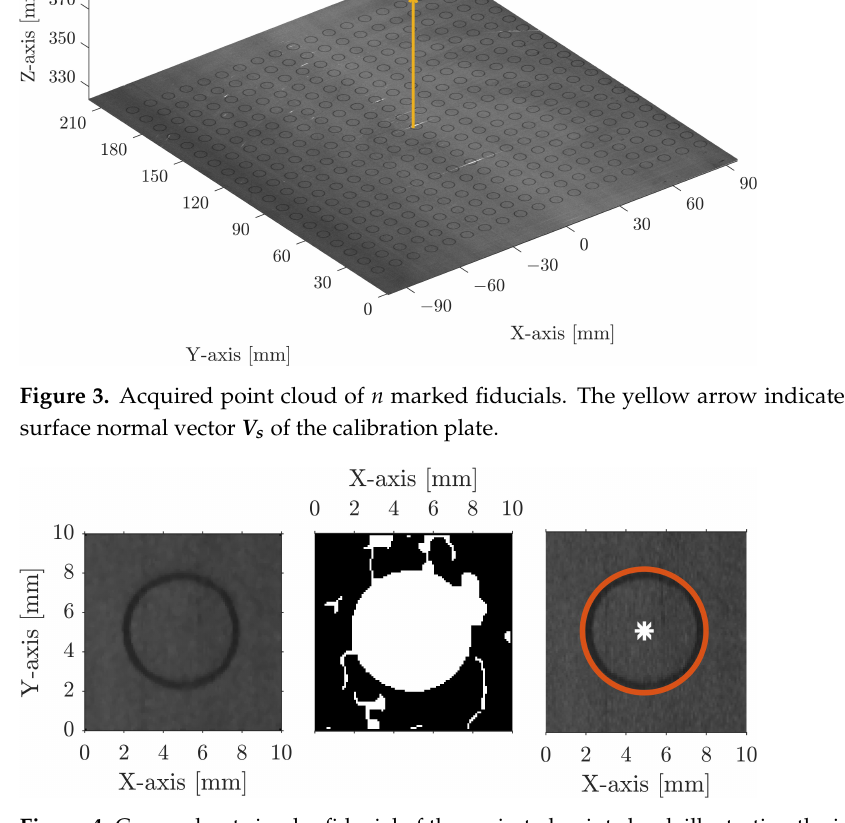
Figure 4. Cropped out circular fiducial of the projected point cloud, illustrating the image processing steps to locate the fiducials. A median filter is applied to the image ( left ), Canny edge detection and morphology ( centre ), and identification of circular patterns using CHT ( right